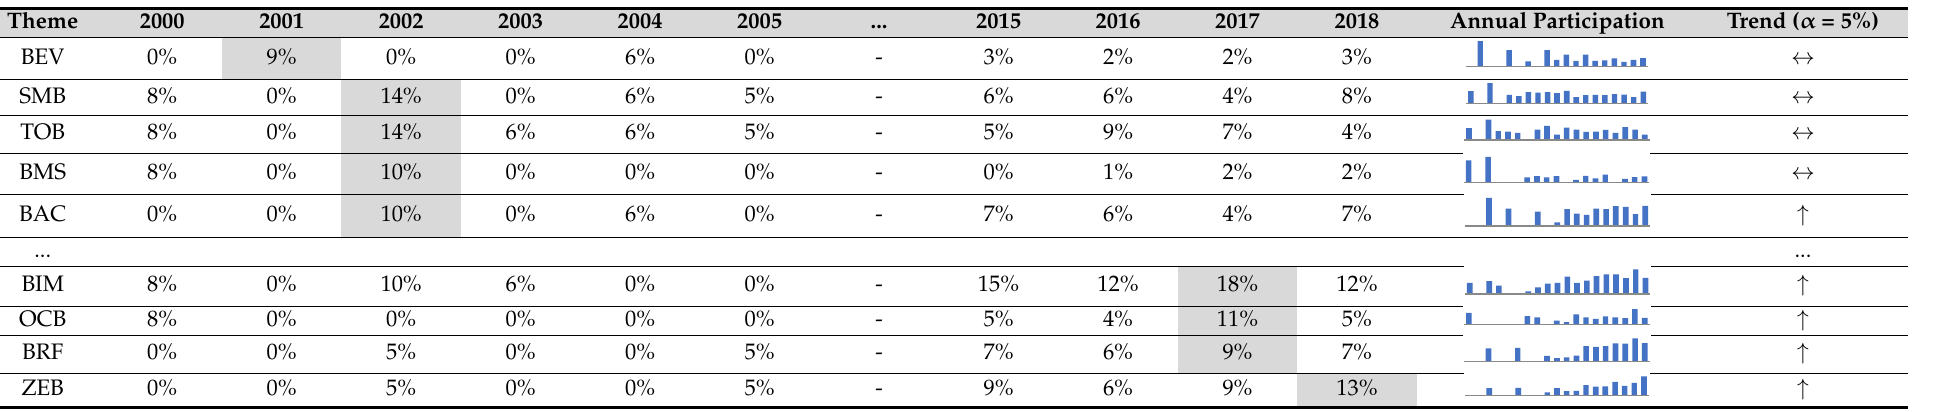
Table 4. Annual participation of the themes, followed by their trends.